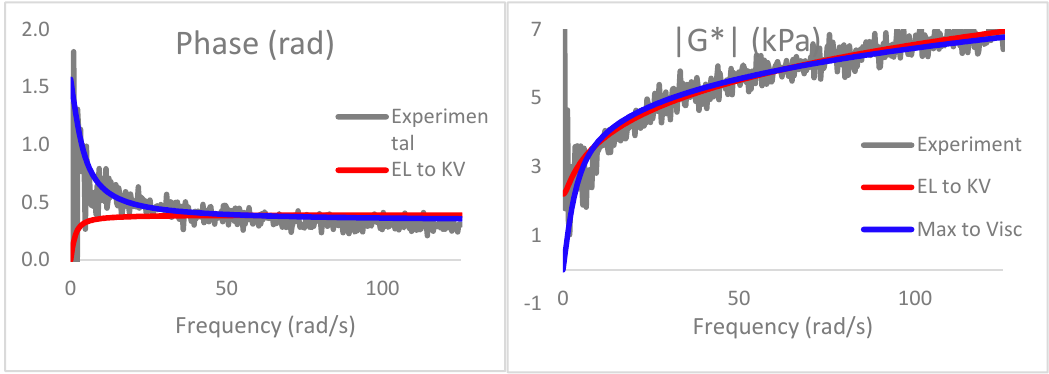
Figure 15. Model fits to experimental data at 72 ° C.